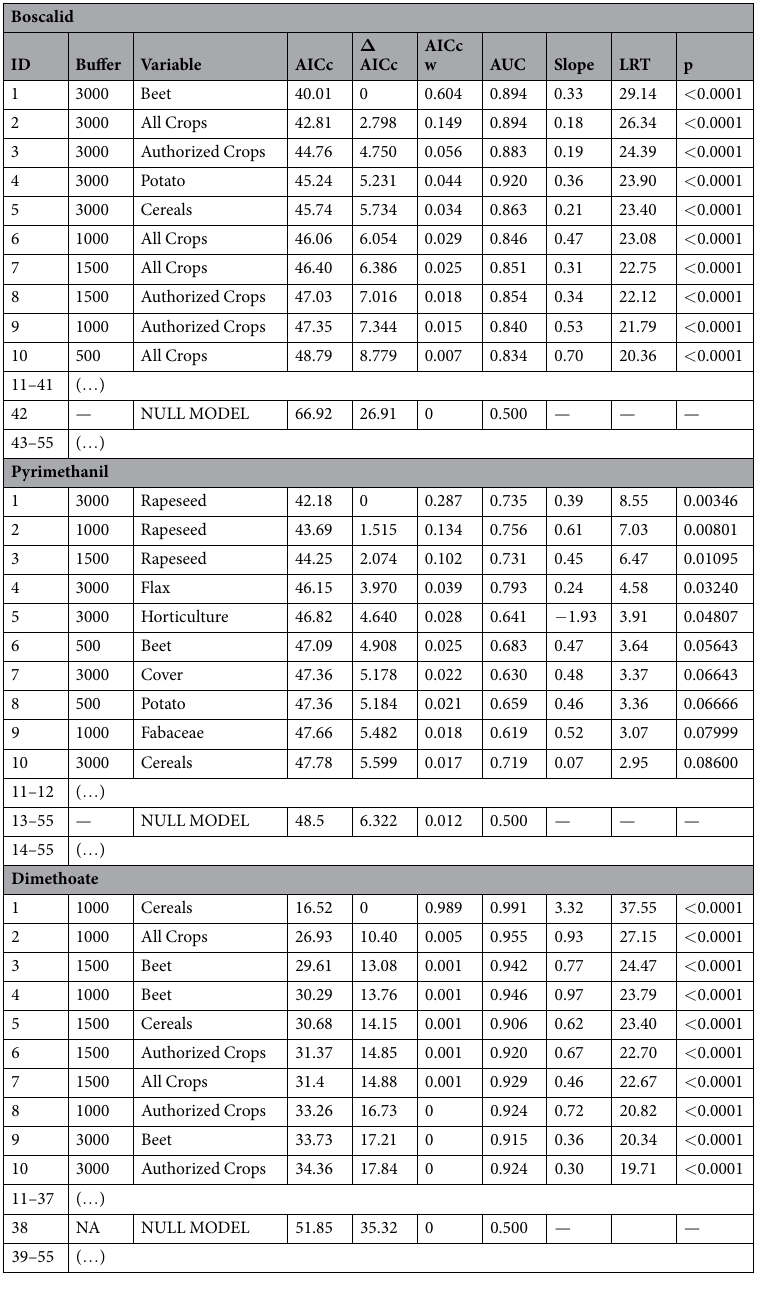
Table 1. Results of univariate Binomial GLMs modeling the probability that a pollen sample would be contaminated by a given pesticide vs the areas of different (groups of) crops and grasslands at different spatial scales (Buffer column, in meters). Only the ten best models (lowest AICc) are shown along with the null model. LRT = Likelihood Ratio Test statistic (degrees of freedom = 1 for all models). Full tables available in the Supplementary Information